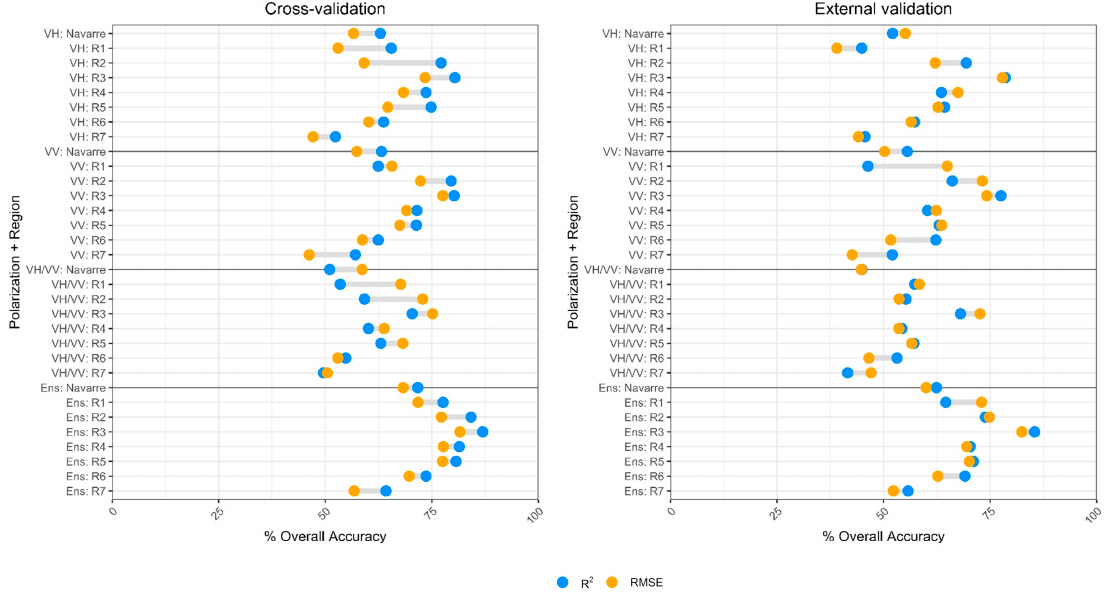
Figure 9. Overall Accuracy of cross-validation classification ( left ) and external validation classification ( right ).